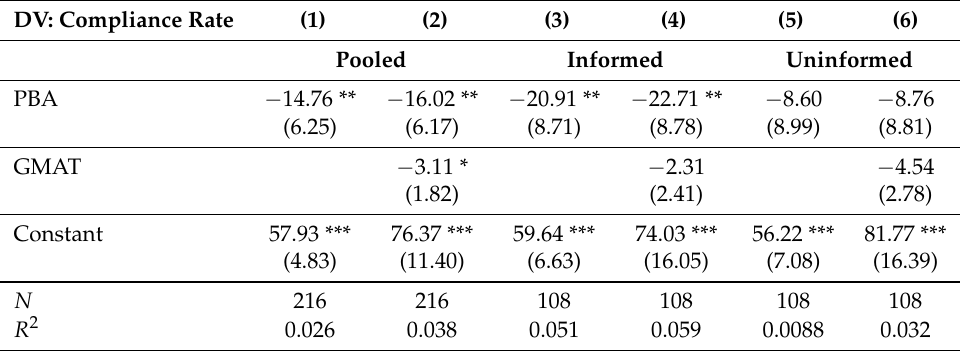
Table 4. Allocation treatment regressions